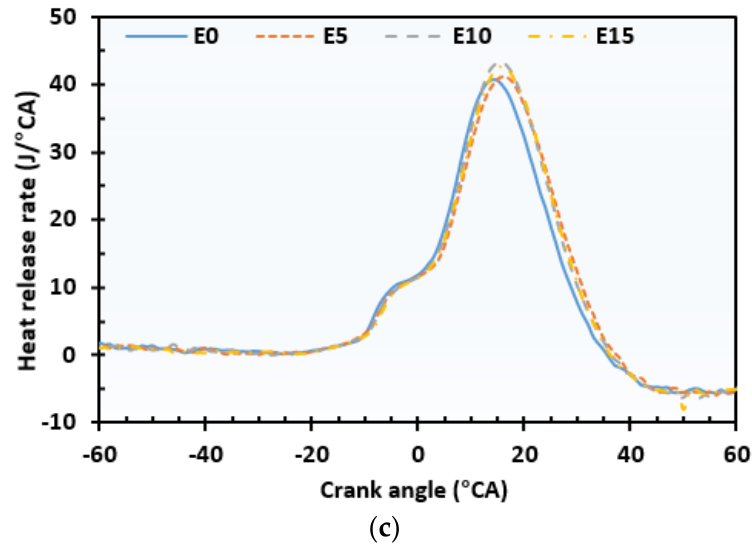
Figure 5. Heat release rate: ( a ) 40 Nm; ( b ) 60 Nm; ( c ) 80 Nm.